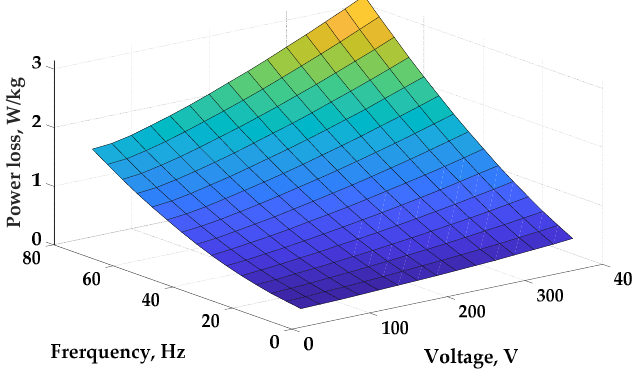
Figure 10. Typical relative core losses vs. magnetic core weight.